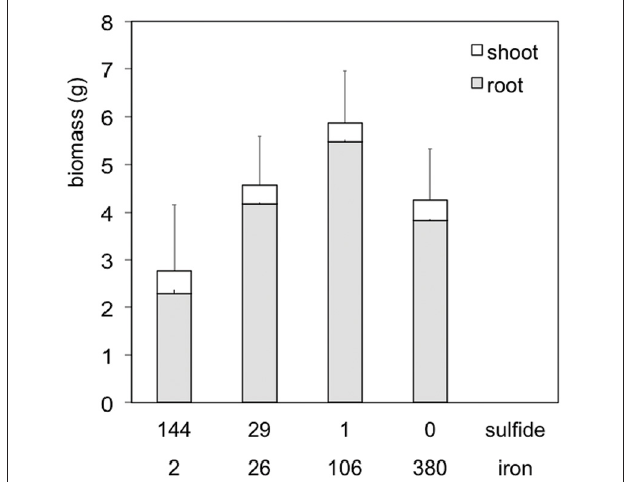
FIGURE 2 | Interacting effects of dissolved sulfide and iron (concentrations in µ mol L − 1 ) in the soil porewater on biomass production of Caltha palustris . Although both compounds may be toxic for plant growth, they detoxify one another as a result of FeS x precipitation (quadratic correlation, p = 0 . 014). Adapted from Van der Welle et al. (2006).